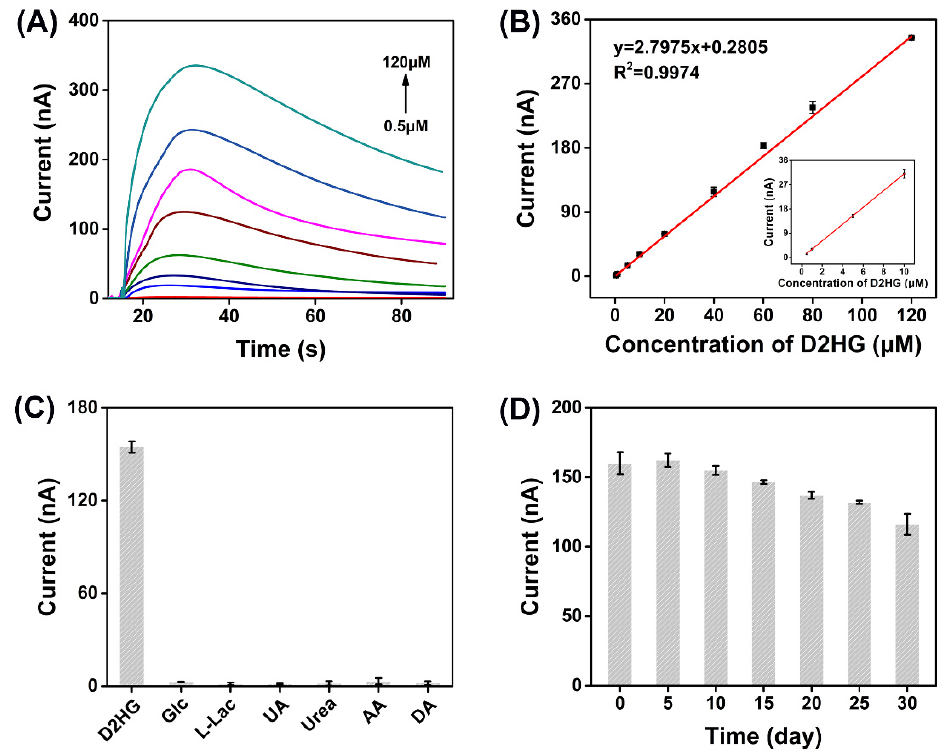
Figure 4. ( A ) I–t curves of the prepared biosensors in 50 mM PB (pH 7.0) with 0.1 M KCl containing 0.5, 1, 5, 10, 20, 40, 60, 80, 120 µ M D2HG. Applied potential: − 0.23 V vs. Ag/AgCl; ( B ) typical calibration plot for D2HG detection using the D2HG biosensors in 50 mM PB with 0.1 M KCl containing